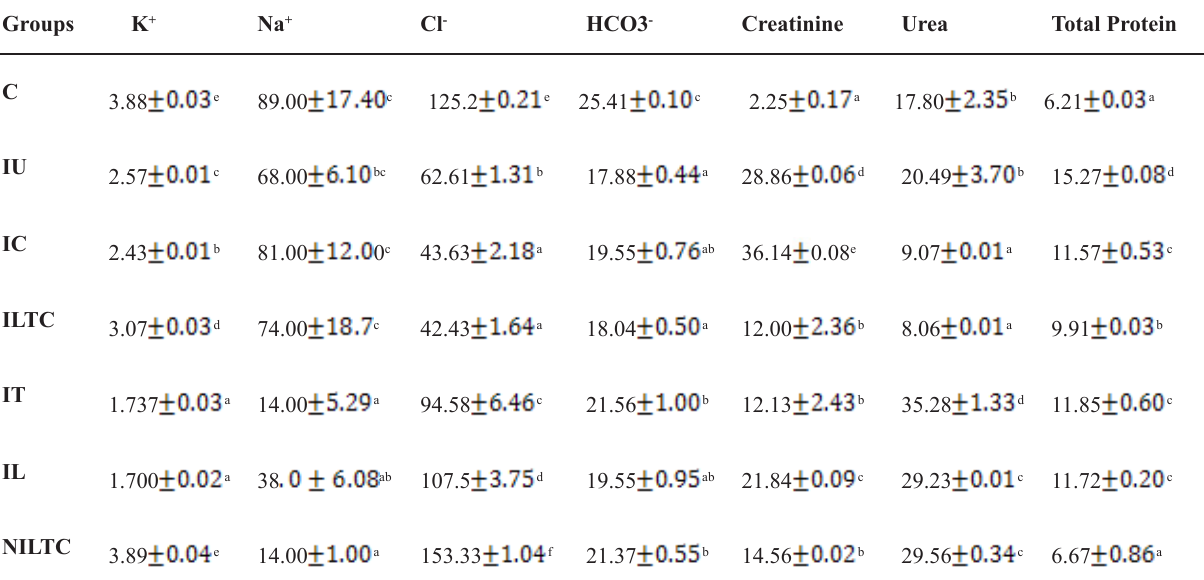
Table 3: Effects of administration of lumefantrine, trimethoprim and lumefantrine trimethoprim-copper complex on biochemical parameters in P.berghei NK-65 infected and non-infected mice.